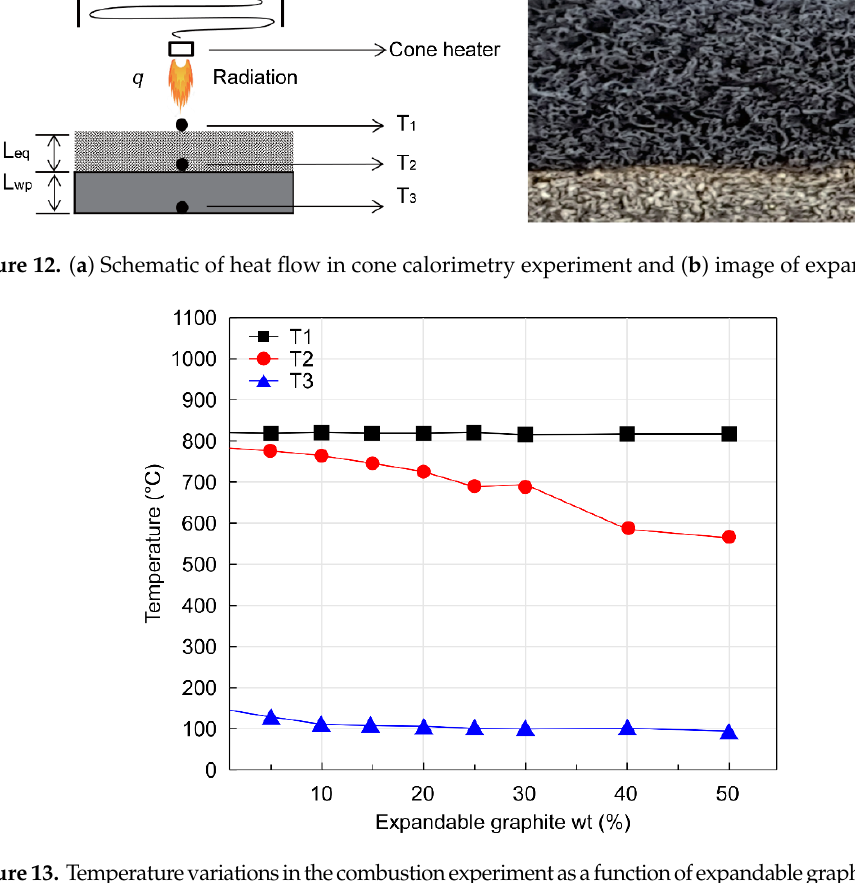
Figure13. Figure 13. Temperature variations in the combustion experiment as a function of expandable graphite content.